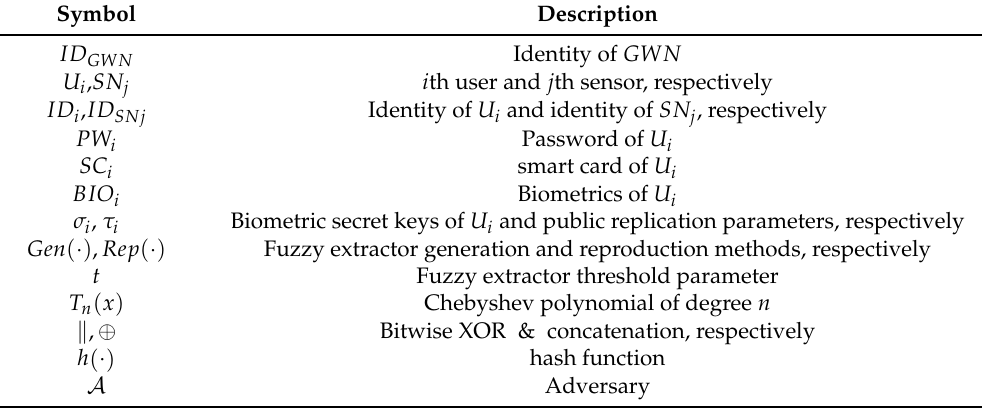
Table 1. The mathematical symbols.